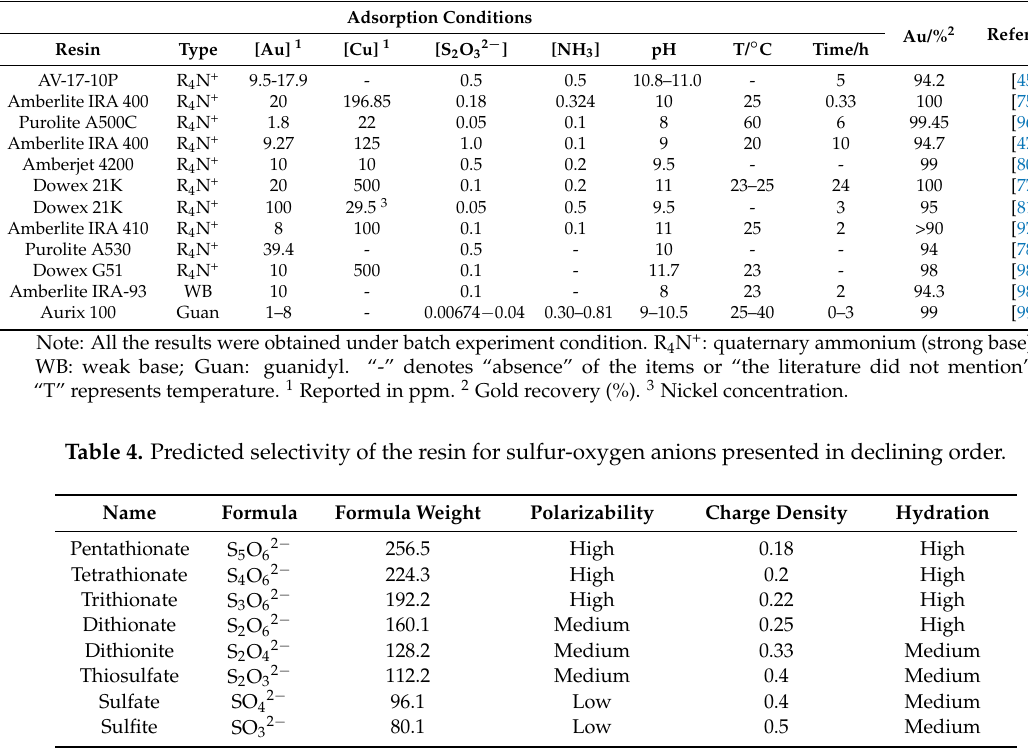
Table 3. The resins used for gold recovery from pregnant thiosulfate solutions.